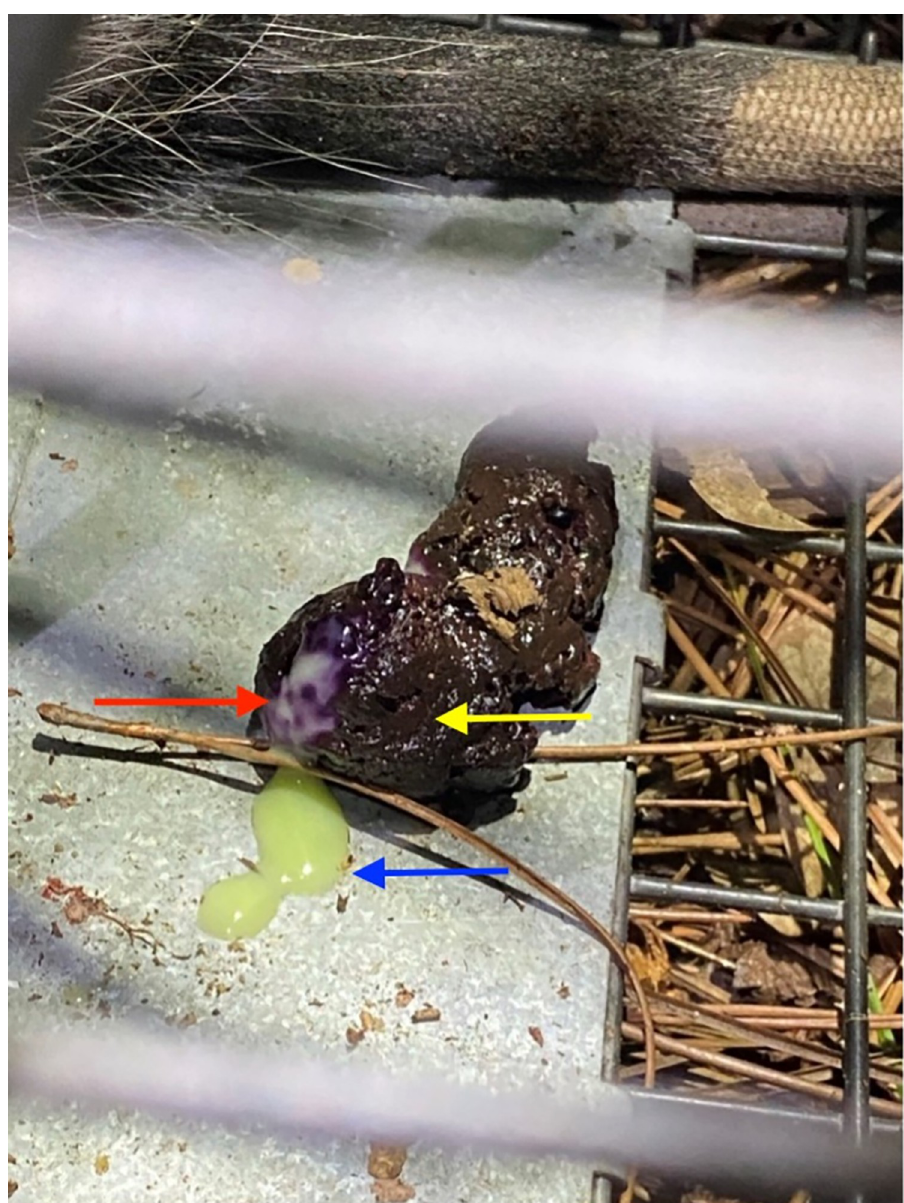
Fig 2. Opossum feces and anal gland secretion. Image depicting opossum feces (yellow arrow) contaminated with anal gland secretion (red arrow). Opossum anal gland secretion (blue arrow) can be seen in close association with the fecal bolus that is sitting on the trigger pan of the Tomahawk livetrap. This individual was sampled but negative for T . cruzi . The tail of the Virginia opossum can be seen in the background of the image. (Photo credit: C. W. Torhorst).